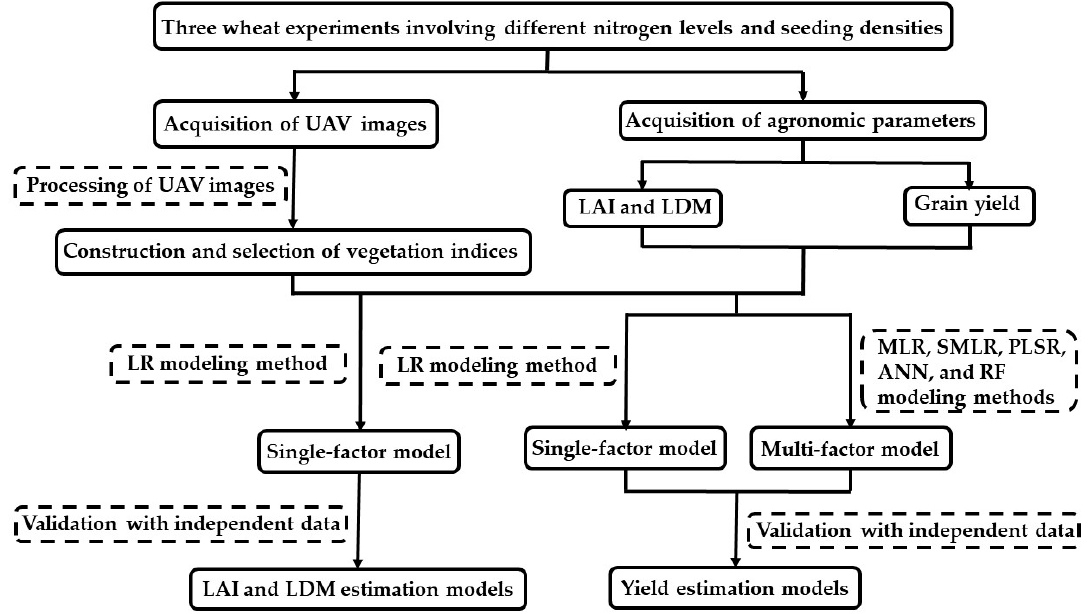
Figure 3. The flowchart of this study.